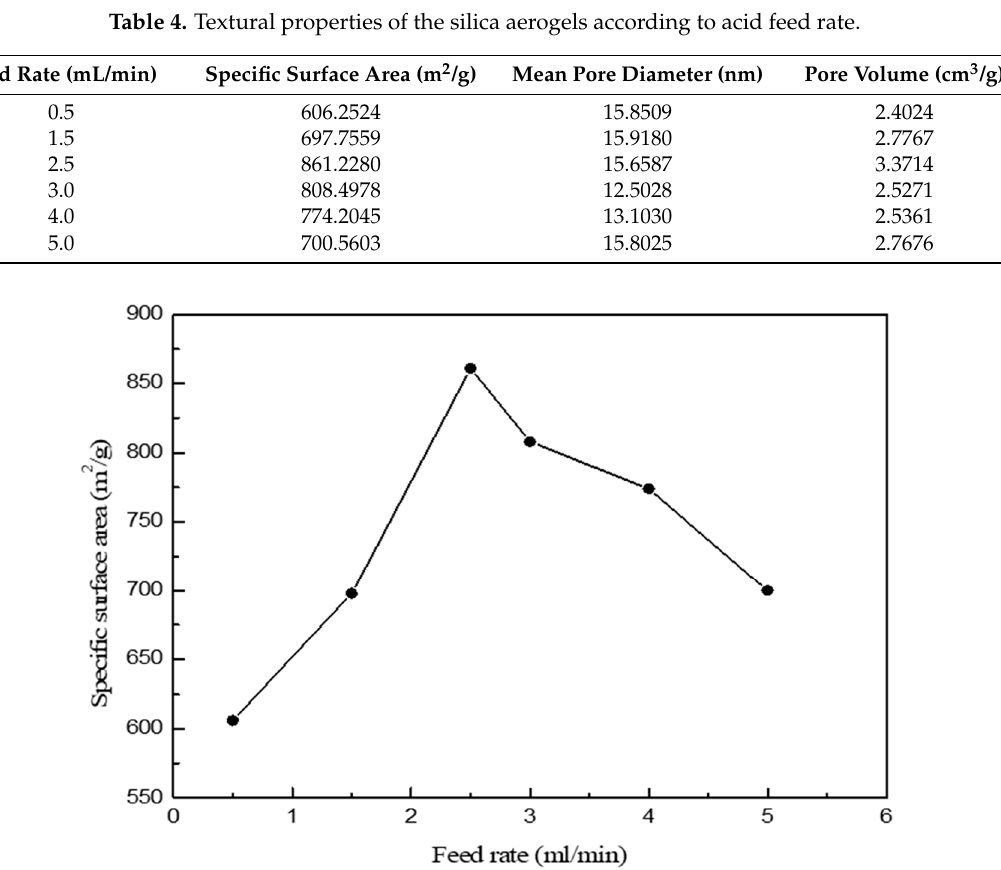
Figure 4. Change in the specific surface area of the silica aerogels depending on the acid feed